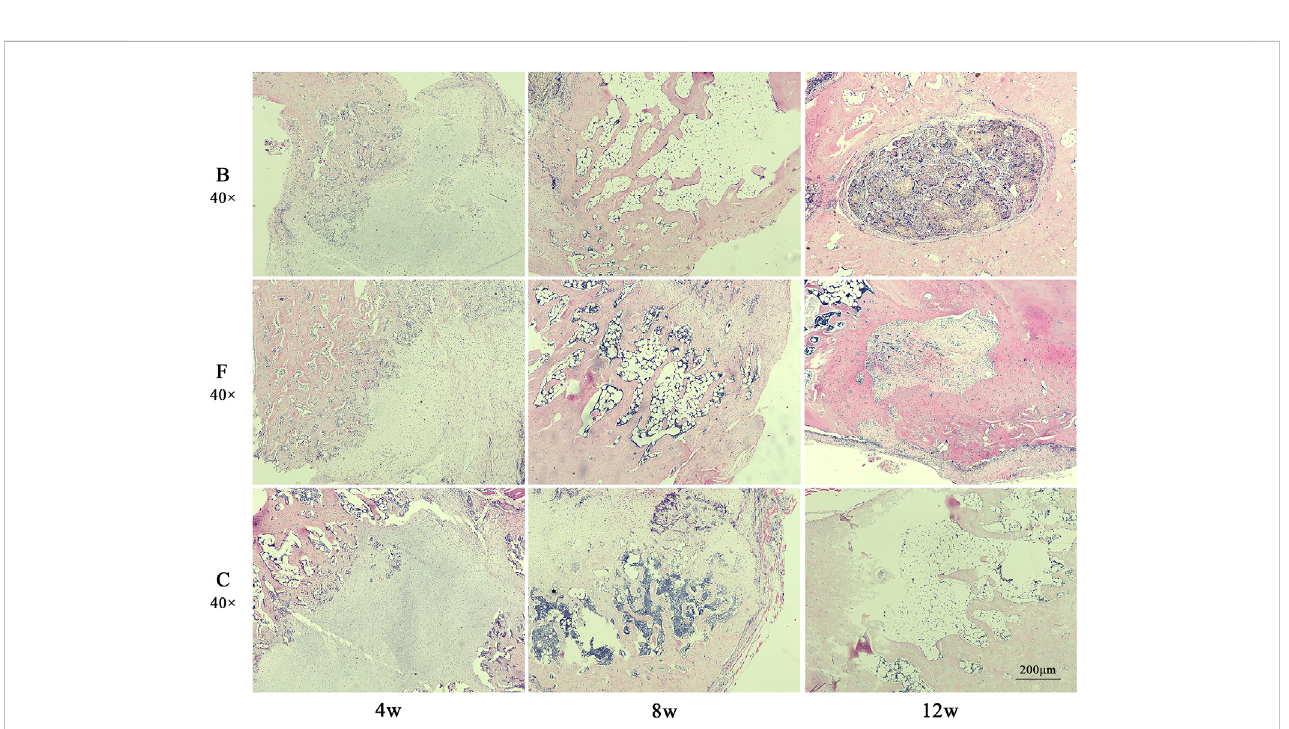
FIGURE 13 The H&E staining map of bone defects in rats. The tissues were taken for H&E staining at weeks 4, 8 and 12 after implantation (magni fi cation,